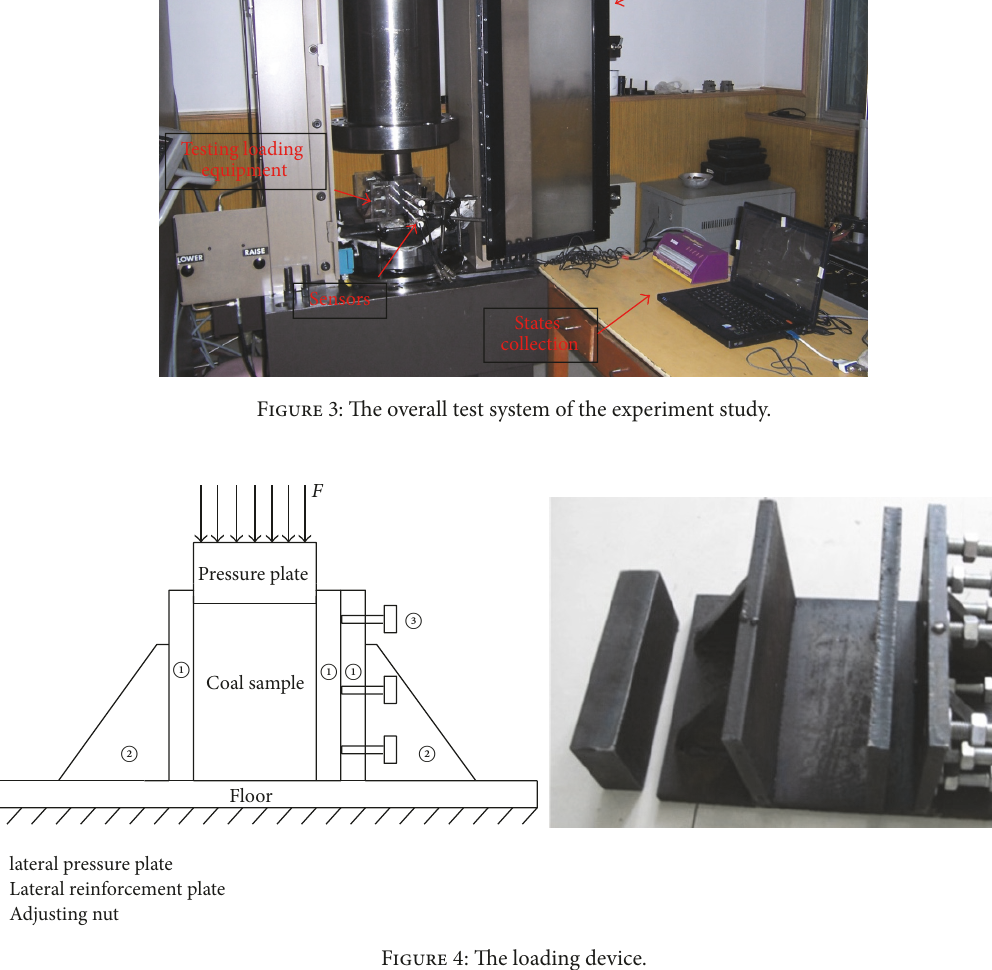
Figure 4: The loading